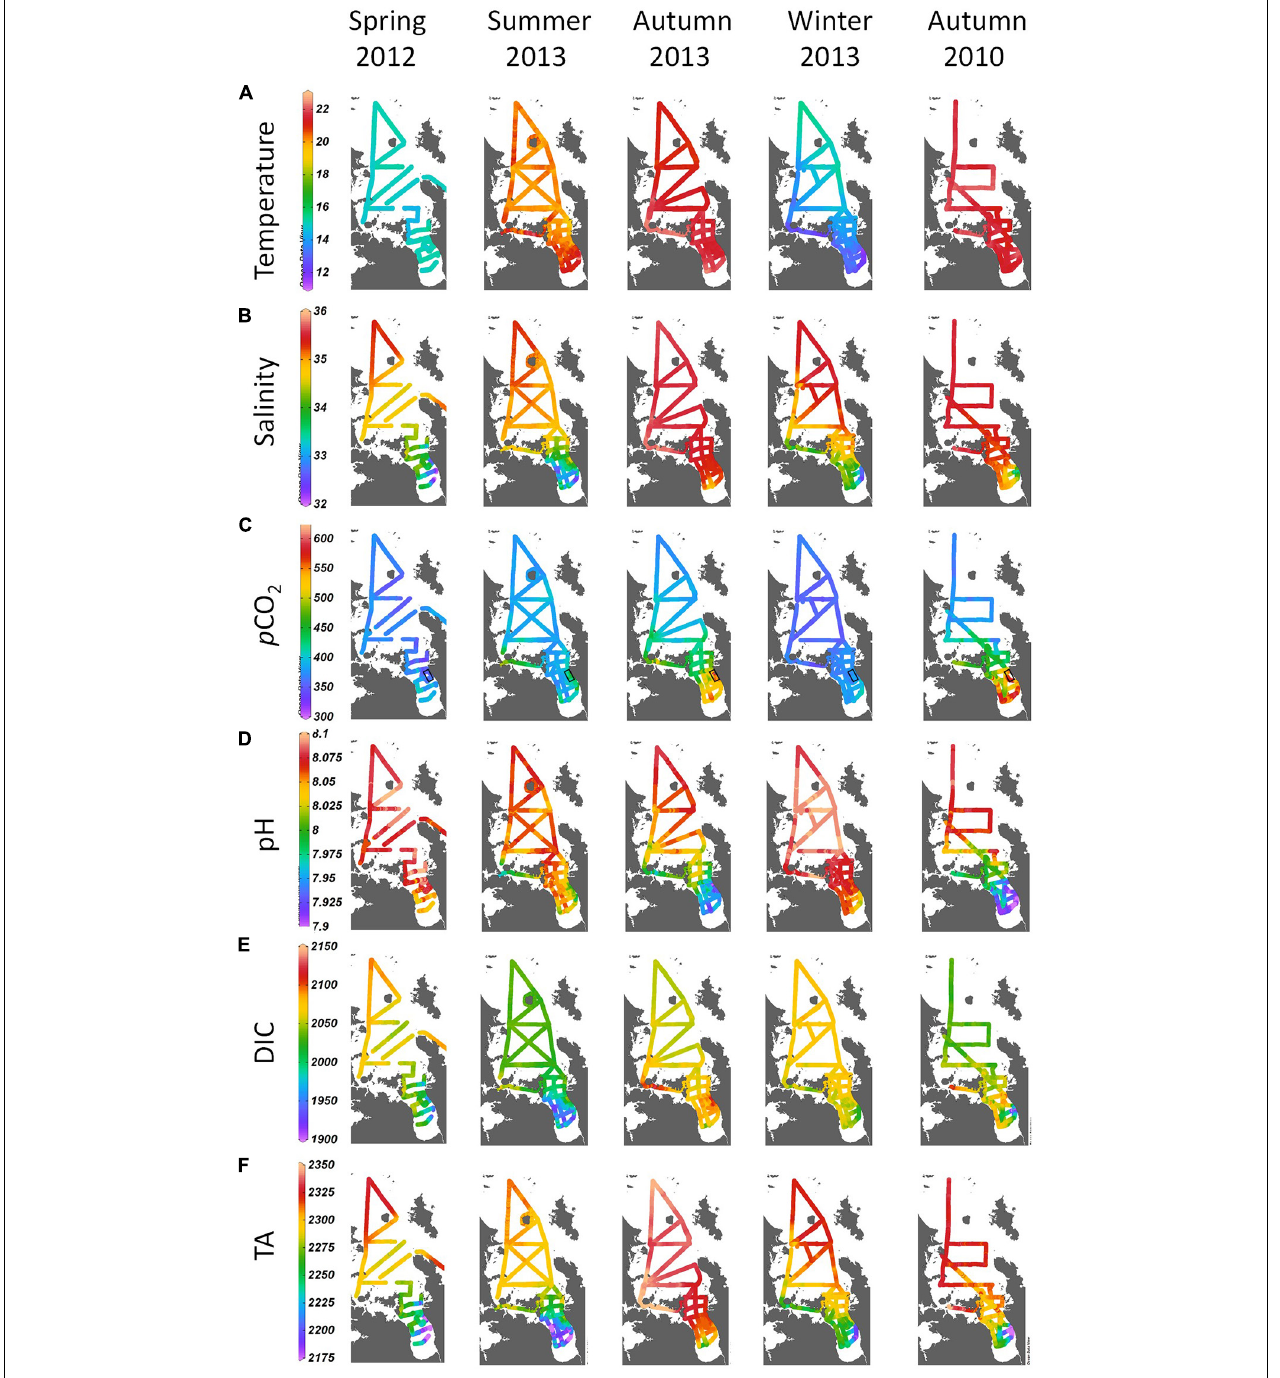
FIGURE 2 | Ribbon plots of surface layer (A) temperature ( ◦ C), (B) salinity (psu), (C) p CO 2 ( µ atm), (D) pH [ − log(H + )], (E) DIC ( µ mol kg − 1 ) and (F) TA ( µ mol kg − 1 ) in spring, summer, autumn and winter from underway surveys in 2012–13 and in autumn 2010 across the NE shelf, Hauraki Gulf and Firth. The black rectangle on p CO 2 plots shows the location of large mussel farms in the eastern